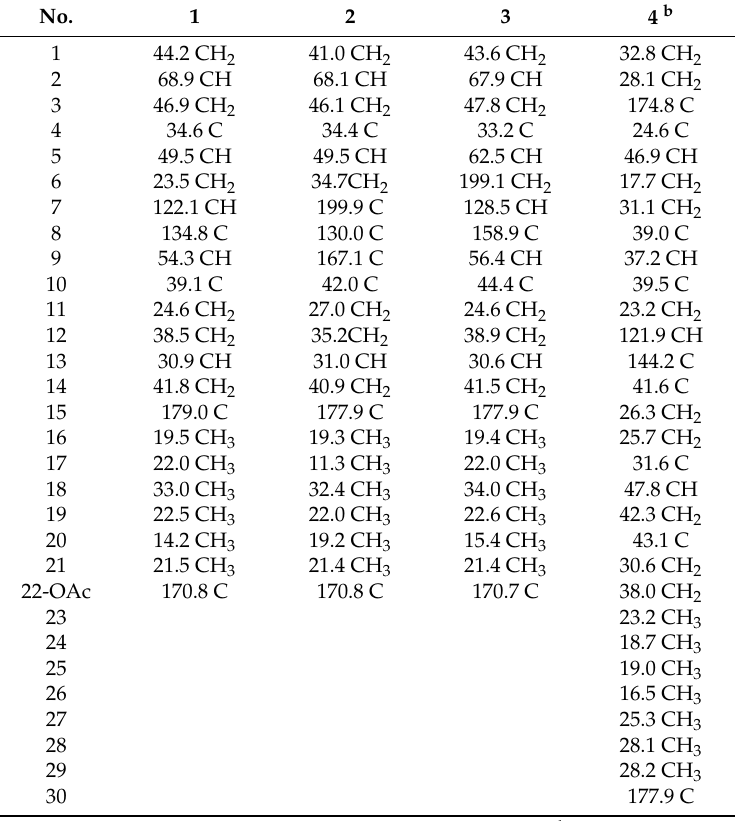
Table 2. 13 C-NMR spectral data (125 MHz, CDCl 3 ) of compounds 1 – 4 a